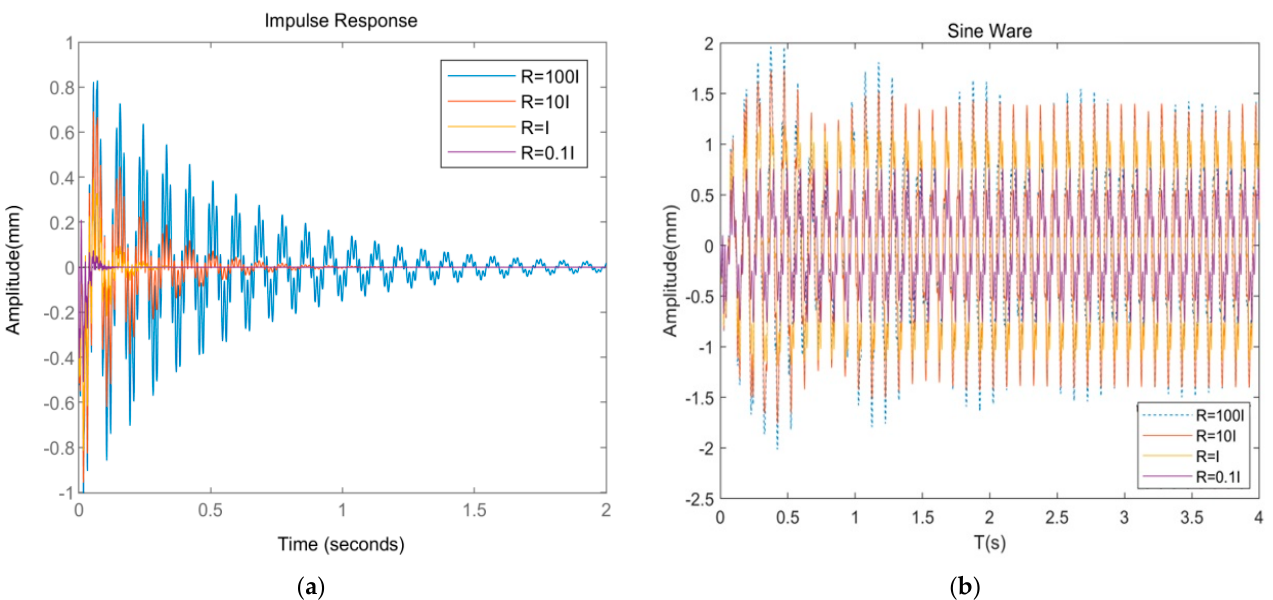
Figure 15. Comparison of system response with different R-matrix coefficients. ( a ) System response under impulse excitation; ( b ) system response under sine wave. Table 5. System response parameters under impulse